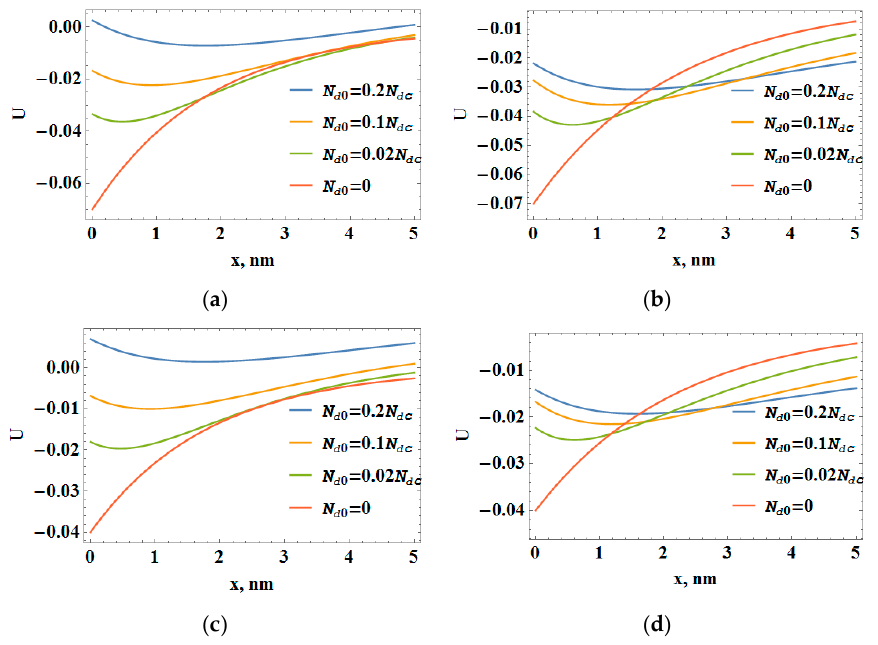
Figure 1. The coordinate dependence of the deformation of the crystal lattice of the InAs film on the GaAs substrate ( a , b ) and the Ge film on the Si substrate ( c , d ) with interstitial atoms ( a , c ) and substitution impurities with a smaller ionic radius ( b , d ) at different values of the average concentration defects. Table 1. Some physical parameters of the film